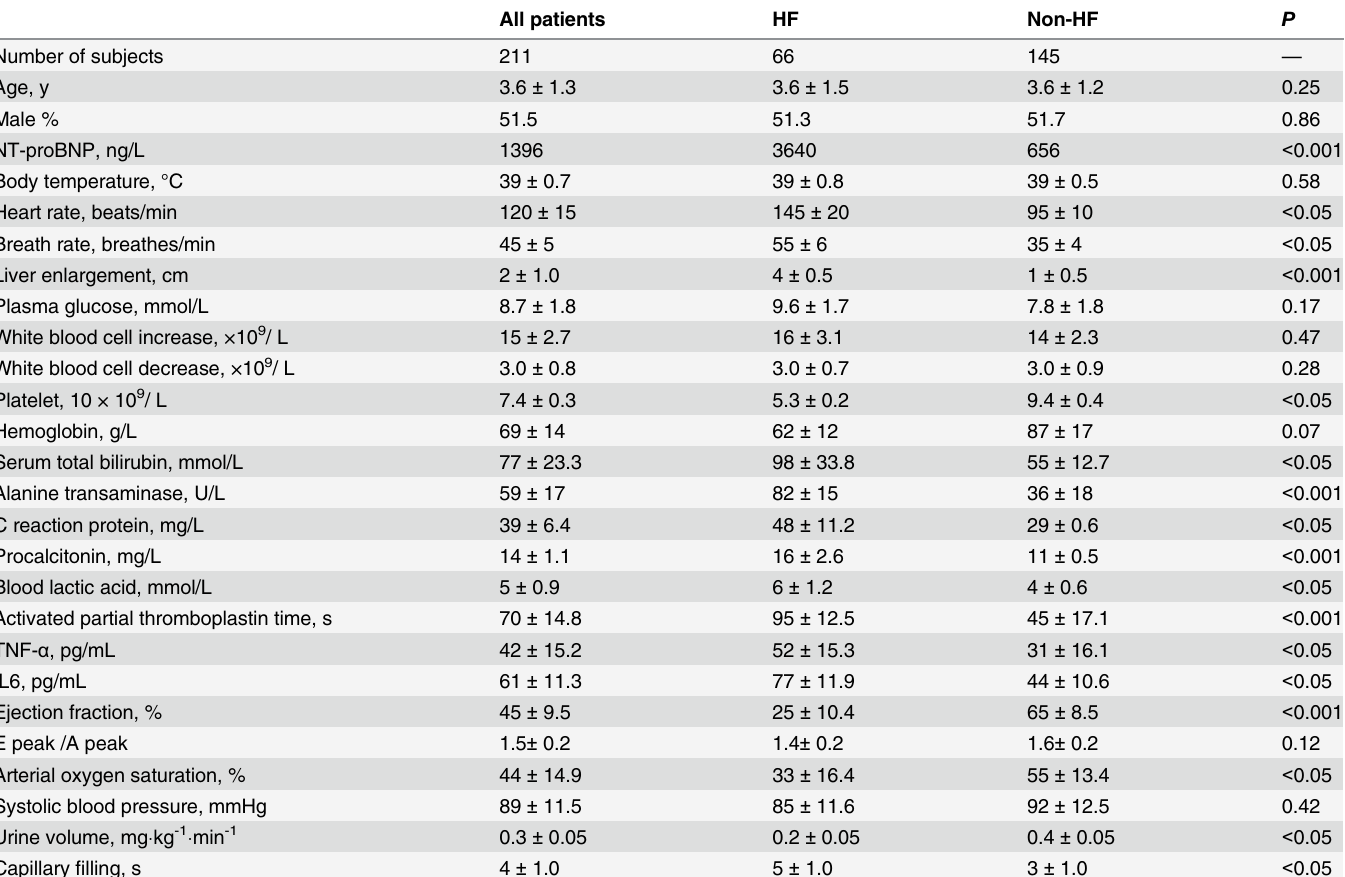
Table 2. Characteristics of pediatric sepsis patients at